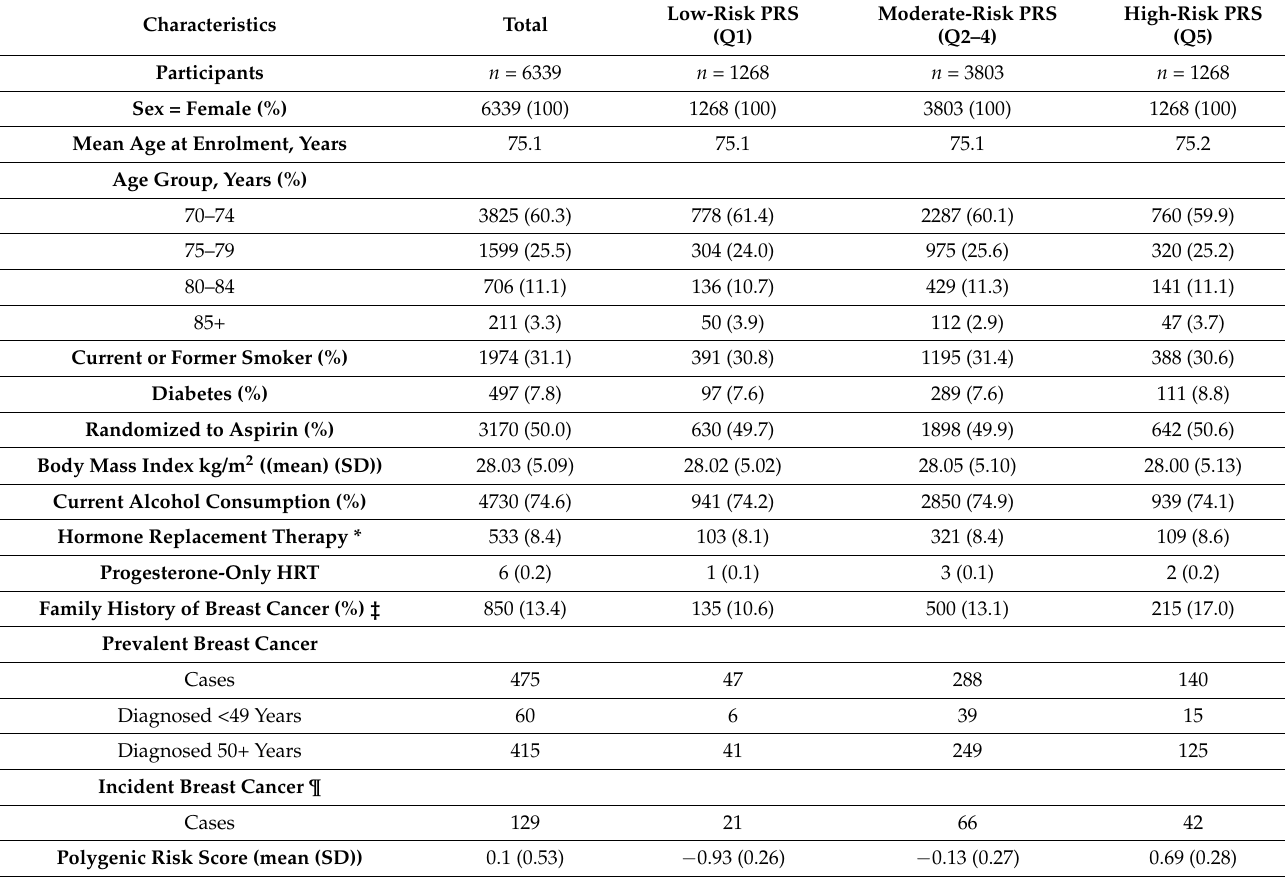
Table 1. Characteristics of the study